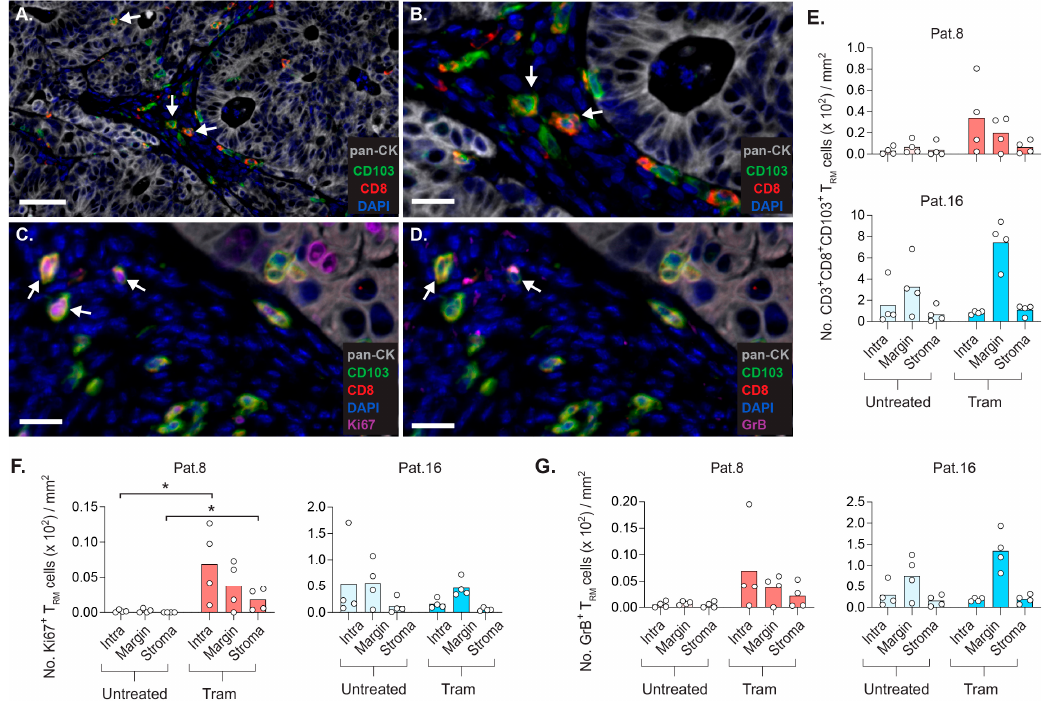
Figure 5. Trametinib promotes increased density of CD8+ T RM cells at specific sites of tumor implant. Tissue staining of CD3+CD103+CD8+ T RM cells and the expression of Ki67 (proliferation marker) and Granzyme B (GrB, involved in T-cell-mediated killing of target cells) in tumor implants of patients 8 and 16. PDX mice were treated as described in Figure 4. ( A ) Pan-cytokeratin (pan-CK)+ tumor epithelia and pan-CK- tumor stroma contained CD3+ TILs with variable CD8 and CD103 expression. Individual cells are defined by DAPI+ cell nuclei. Arrows denote CD8+CD103+ T RM cells in stromal and intraepithelial tumor compartments. The arrows indicate T RM cells ( B ) and examples of CD8+ T RM cells expressing Ki67 ( C ) or GrB ( D ). ( E ) Density of CD8+CD103+ T RM cells within tumor epithelia (intra) and at the tumor margin (0–49 µ m away from tumor bed) or stroma (50–100 µ m away from tumor bed). Density of CD8+CD103+ T RM cells expressing Ki67 ( F ) or GrB ( G ). Scale bars: 50 µ m in A, and 20 µ m in B-D. (* p < 0.05, Mann–Whitney